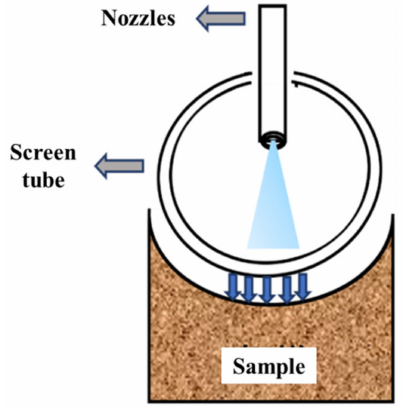
Figure 1. Experiment principal diagram.